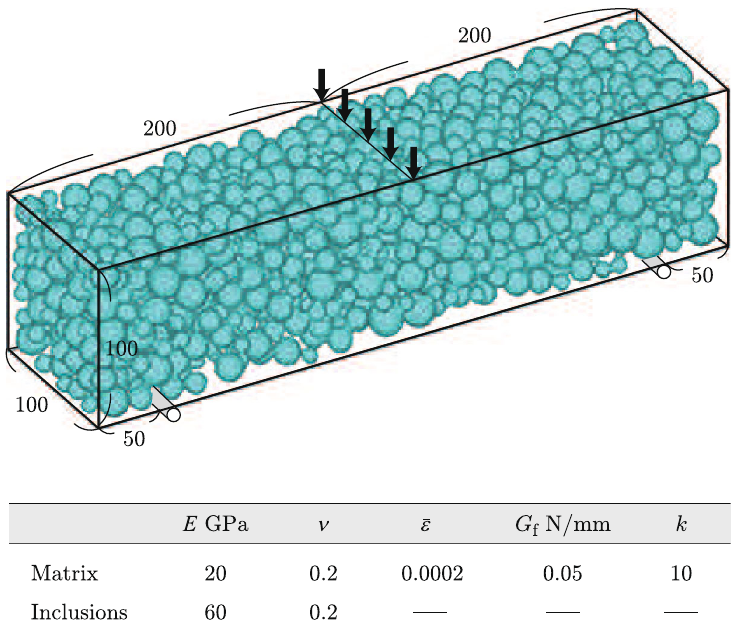
Fig. 11 Three-point bending problem for beam with many spherical inclusions